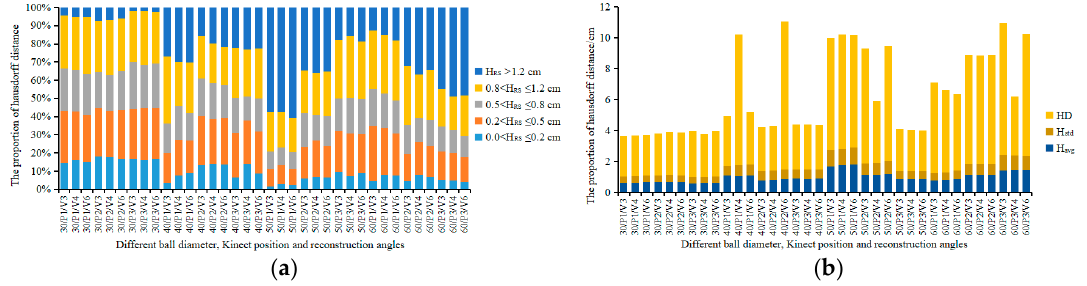
Figure 3. Analysis of point cloud reconstruction of the SSBs: ( a ) Distribution of the H RS sets of the SSBs; ( b ) Metrics for assessing the accuracy of SSB 3D point cloud reconstruction. SSBs; ( b ) Metrics for assessing the accuracy of SSB 3D point cloud